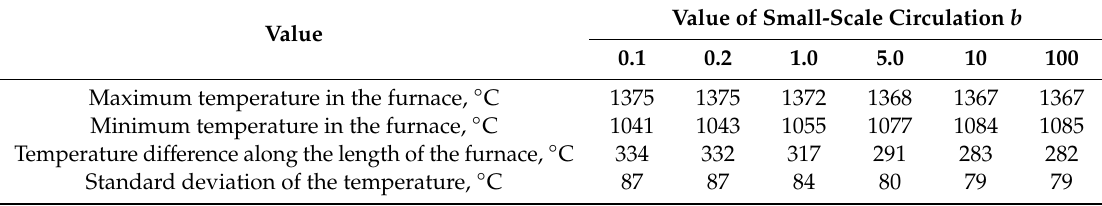
Table 5. Distribution of the mass flow rate of furnace gas streams in pairs of furnace zones depending on the small-scale circulation exponent b .